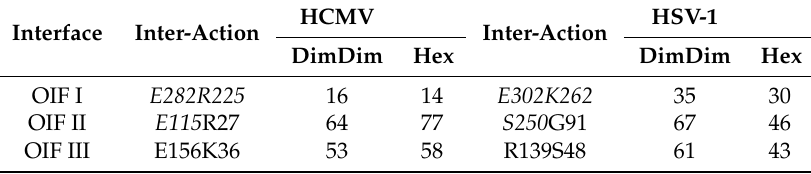
Table 1. Stability of the polar interactions in the oligomer interfaces. The analysis was performed for a DimerDimer (“DimDim”) and the Hexagons (“Hex”). Residues belonging to pUL53 (pUL31) are indicated in italics. All values give the percentage of the simulation time, for which the respective interaction was